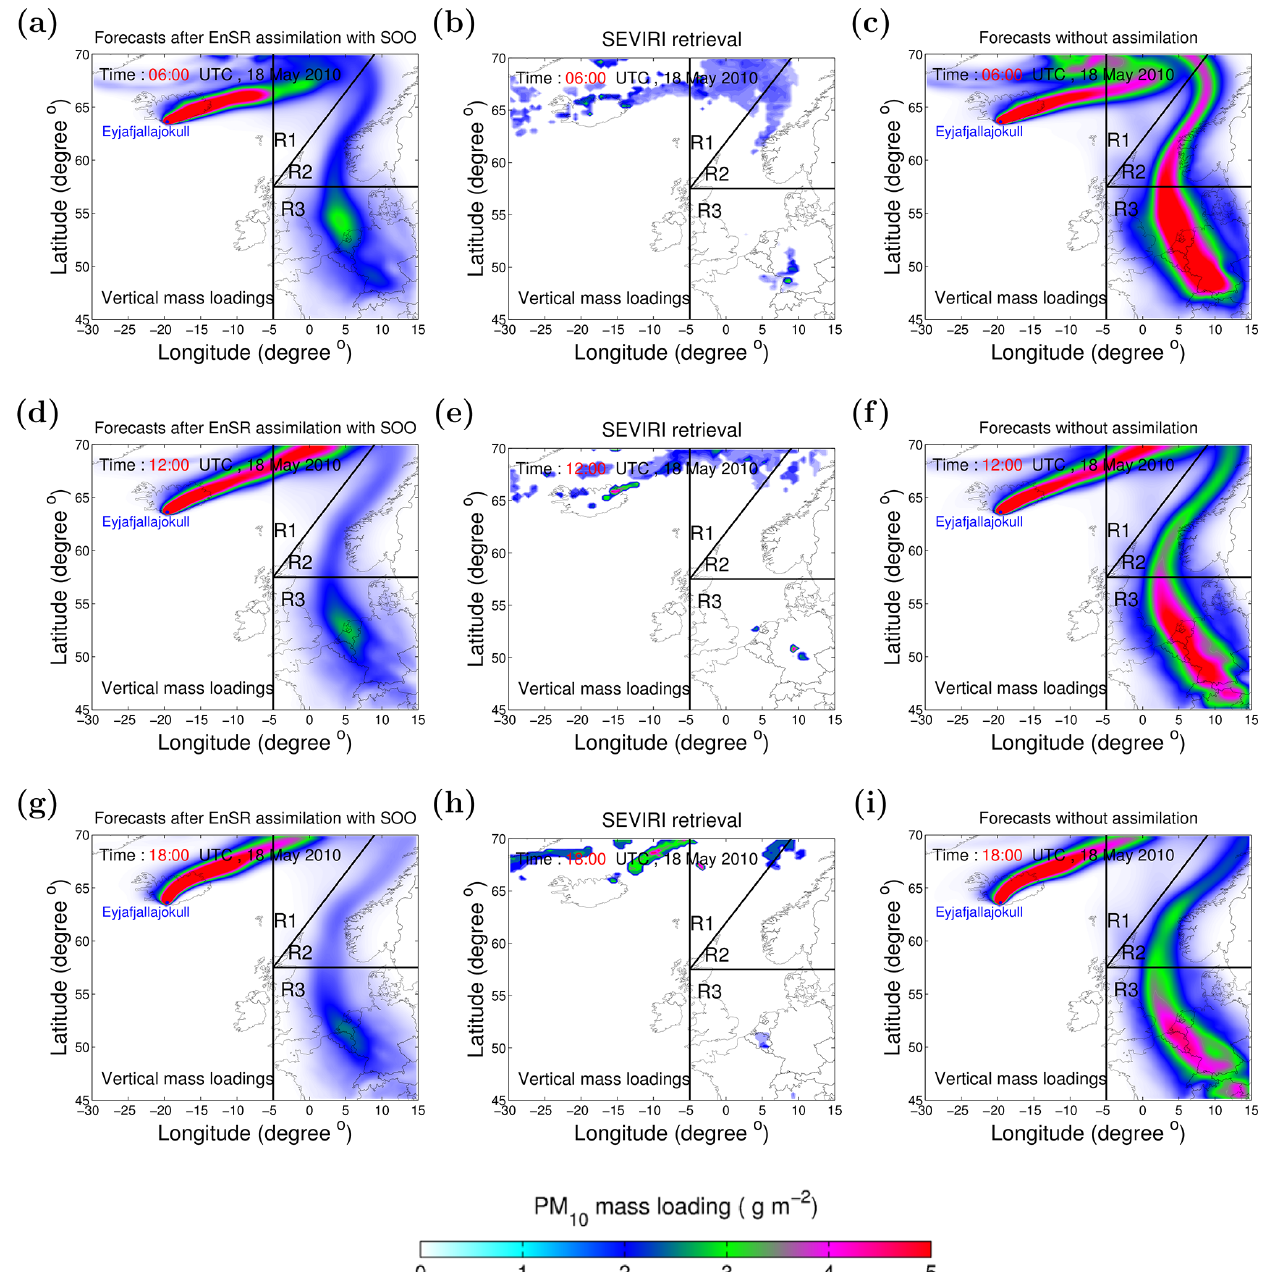
Figure 8. Evaluation of effective assimilation forecasts using satellite-retrieved mass loadings (18 May 2010). R1–R3 represent the three distal regions to be evaluated with respect to the forecast after data